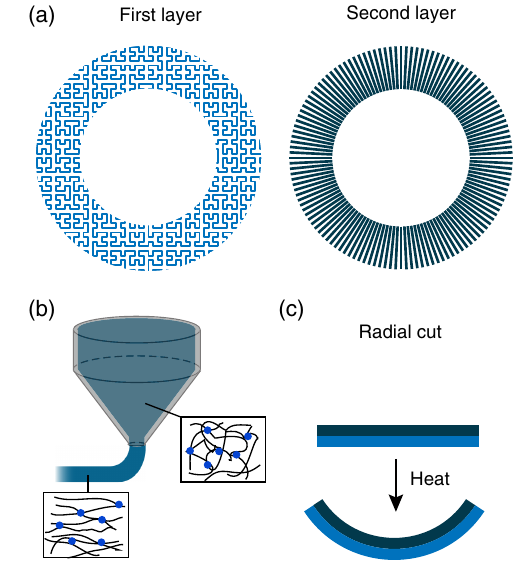
FIG. 6. 3D-printed thermoplastic ribbons. (a) Radial lines (second layer) are printed on top of a layer printed along a Hilbert curve (first layer). (b) Long polymeric chains straighten in the nozzle due to the extensional flow. Cooling down, this elongated configuration results in residual stresses along the printing direction. When heated above the glass transition temperature, the printed thermoplastic material shrinks in the printing direction to release the residual stresses. (c) While the top layer shrinks radially, the bottom layer is mostly passive due to its thickness and the isotropic pattern, inducing thus a radial reference curvature (see Movie 1 in Supplemental Material